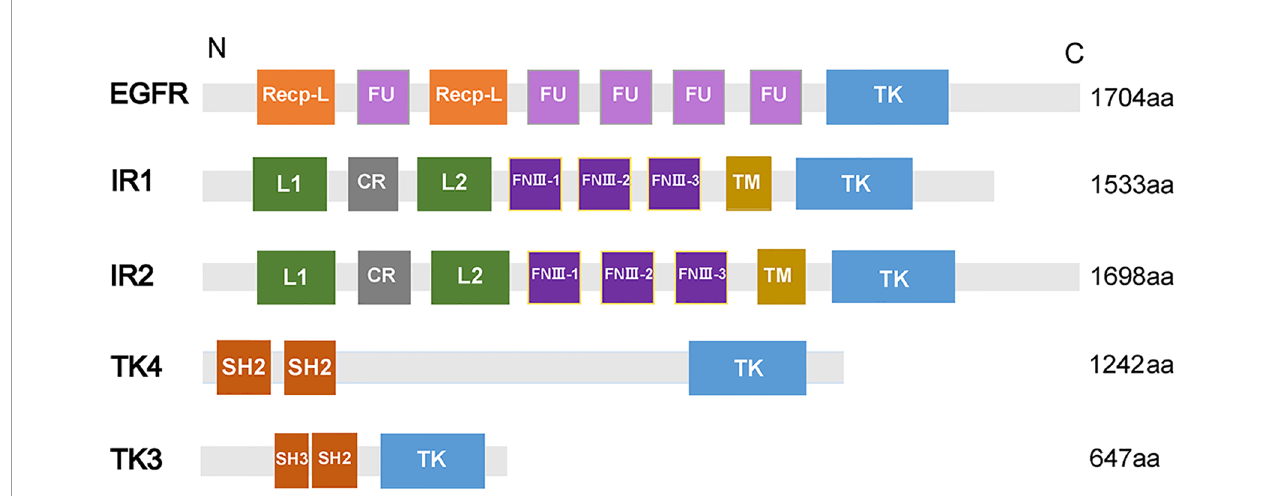
FIGURE 2 | Domain structures of PTKs family. The domain structures including Receptor L domain (Recep-L), Furin-like repeats (FU), ligand binding loop 1 (L1), ligand binding loop 2 (L2), Cysteine-rich region (CR), Fibronectin type III domain (FnIII-1, FnIII-2, FnIII-3), Transmembrane domain (TM), Src homology domain (SH2, SH3), Tyrosine kinase domain (TK). The lengths of amino acid sequences and domain structures of different PTKs are different.